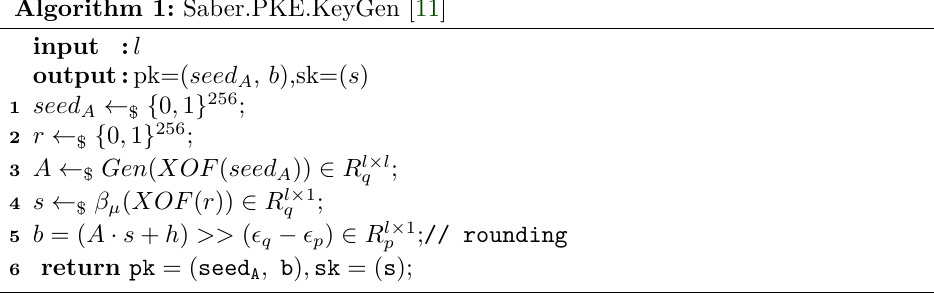
Algorithm 1: Saber.PKE.KeyGen